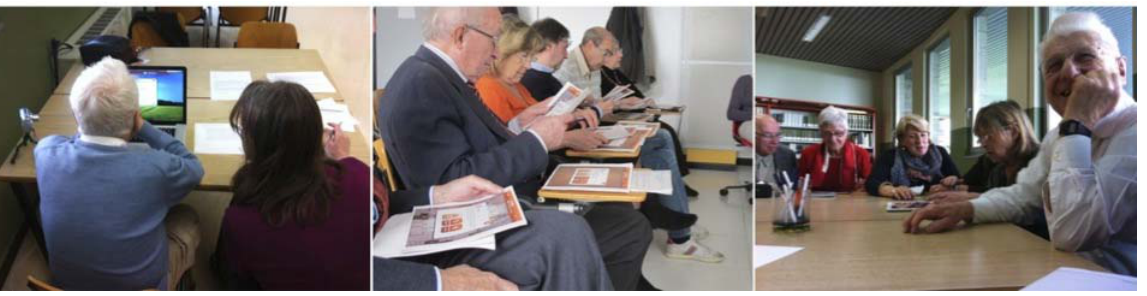
Figure 2. Pilot phase activities with the users: usability tests, co-design workshops, Living Lab